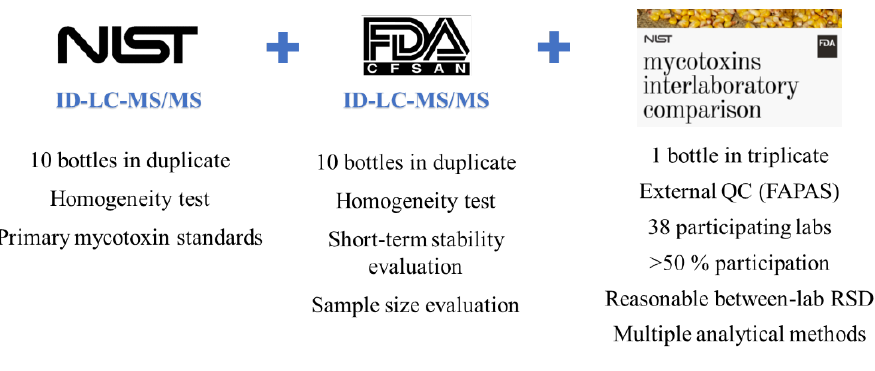
Figure 3. Value assignment of SRM 1565.